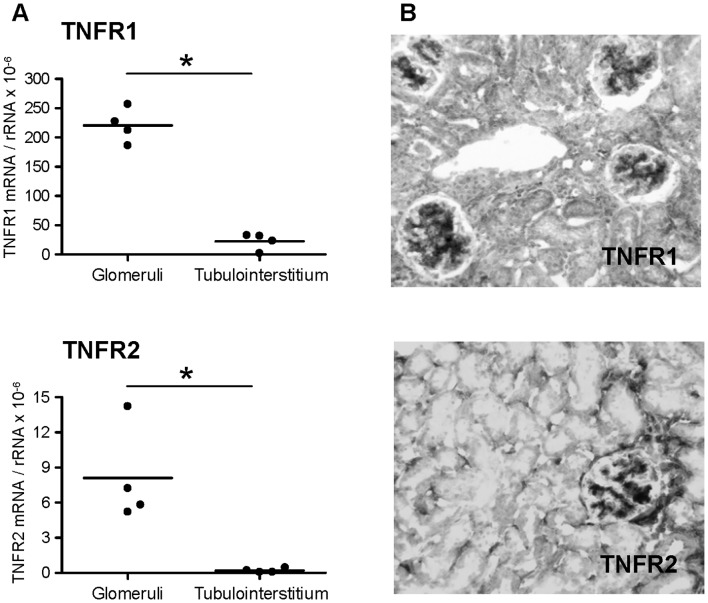
Expression of TNFR1 and TNFR2 in mouse kidney.
A: Compartment-specific expression of TNFR1 and TNFR2 mRNA in glomeruli and tubulointerstitial tissue isolated from normal mouse kidney as analyzed by quantitative real-time PCR. Values were normalized to rRNA expression used as reference gene. ∗ p<0.05. B: Immunohistochemistry on frozen sections for TNFR1 and TNFR2 protein demonstrates a prominent glomerular expression of both receptors (black color product) in normal mouse kidney. Original magnification x200.